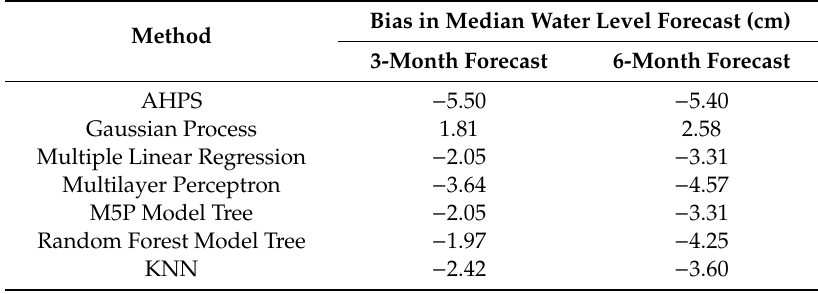
Table 4. Performance comparisons between AHPS and multiple ML models.